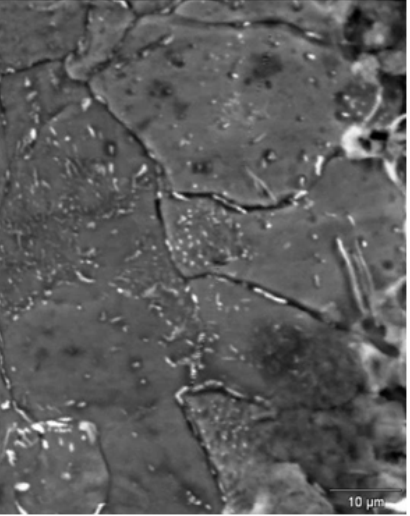
Figure 14: SEM analysis. Section view of the pit. Intergranular damage. – 2200 X.